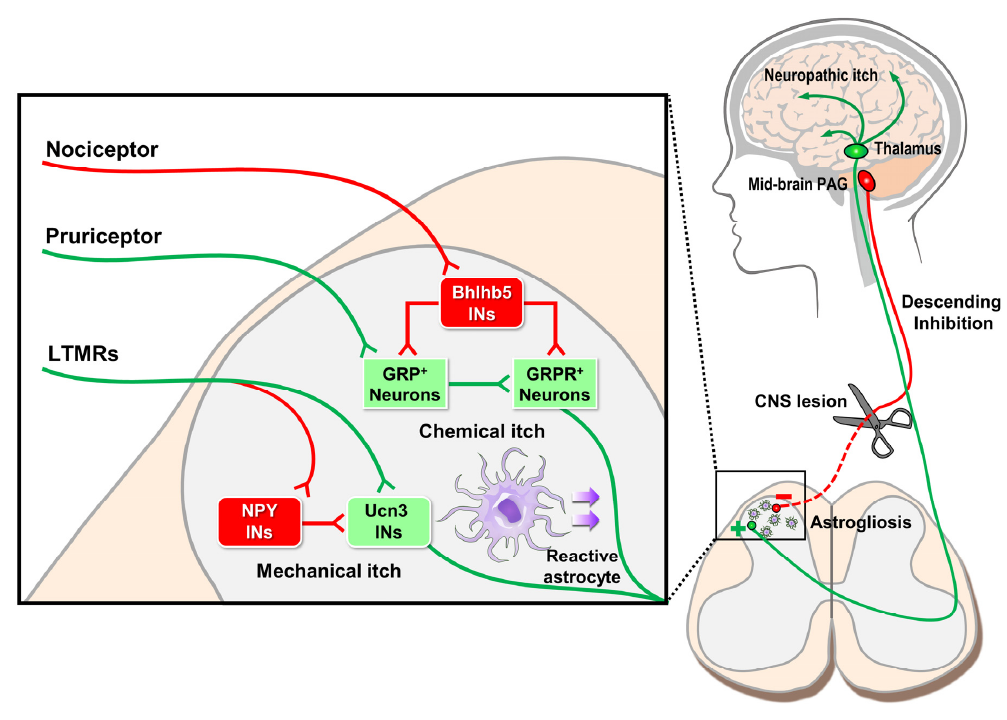
Figure 3. Neuropathic itch of the central nervous system. Peripheral itch nerves synapse with secondary Gastrin-releasing peptide (GRP) + itch neurons of the spinal cord which then activate tertiary GRP receptor (GRPR) + neurons. GRPR + neurons decussate anteriorly to form the spinothalamic tract and synapse with thalamic neurons which communicate with various